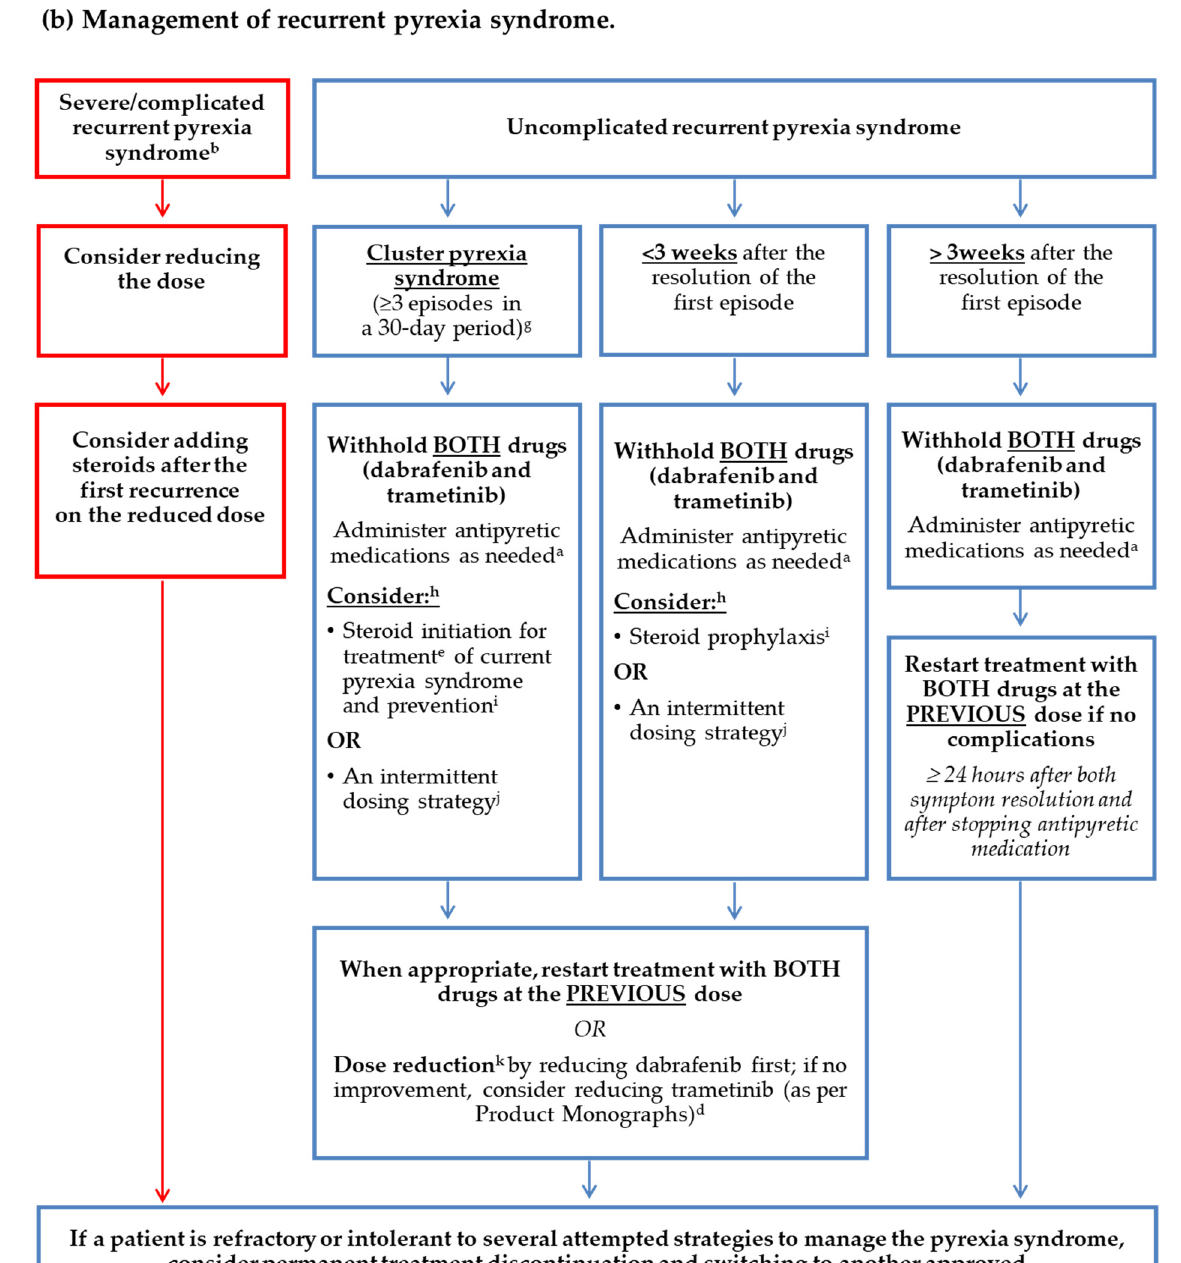
Figure 2. Algorithm based on Canadian Consensus Statements: ( a ) Management of the first occurrence of pyrexia syndrome; ( b ) Management of recurrent pyrexia syndrome. a Acetaminophen should be given 1 g q 4 to 6 h and not exceeding 4 g per day; Ibuprofen should be given 400 mg q 4 to 6 h and not exceeding 1.2 g per day if self-administering, or 3.2 g per day under close monitoring. b Severe/complicated pyrexia syndrome is defined as pyrexia syndrome requiring hospitalization or